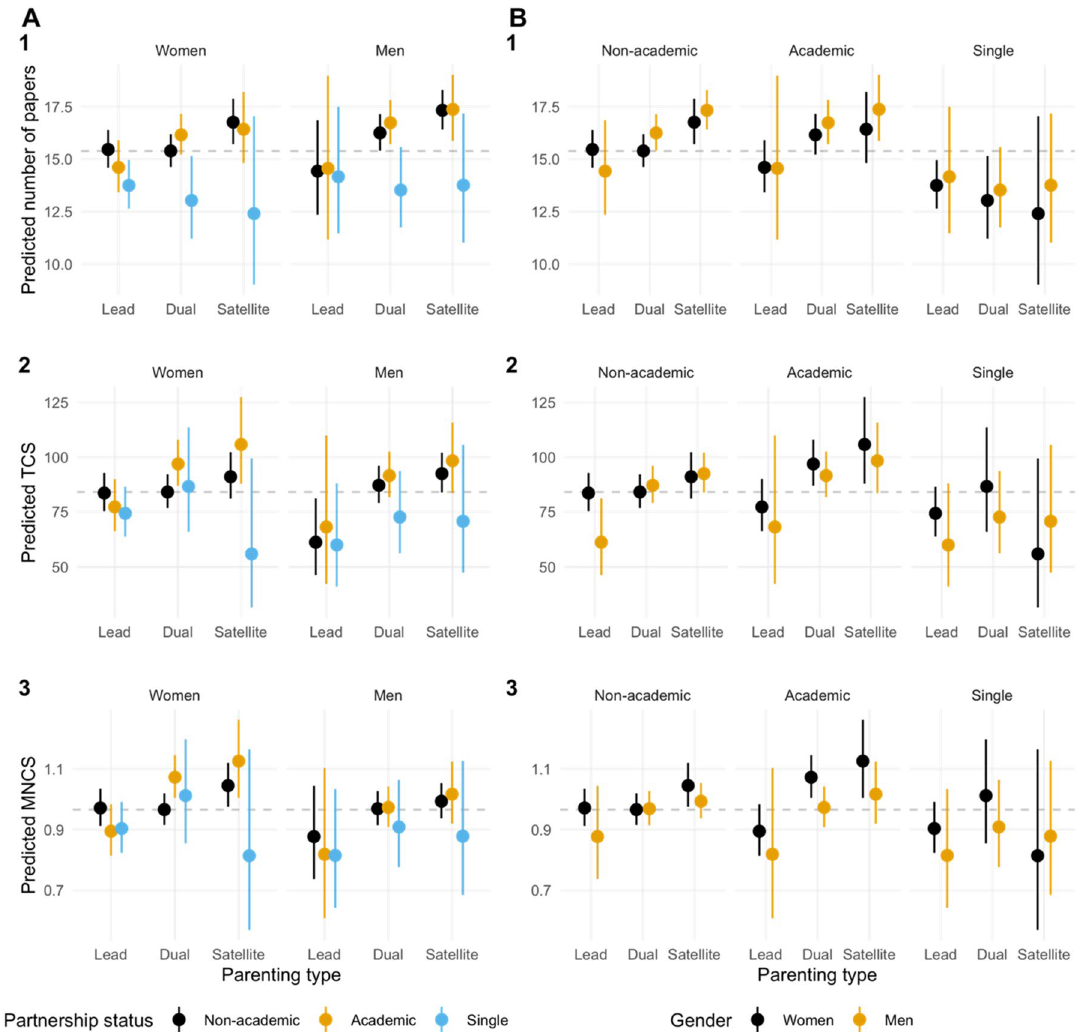
Figure 5. Predicted productivity/impact based on parenting type, gender, and partnership status, faceted by ( A ) gender, ( B ) partnership status: (1) total number of papers, (2) total number of citations (TCS), (3) mean normalized citation scores (MNCS). The dash line refers to the predicted productivity/impact of our reference group: dual mothers with a non-academic partner. Results are averaged over the levels of number of children, academic employment status, doctoral degree, and domain (except for MNCS). Intervals are back-transformed from the log